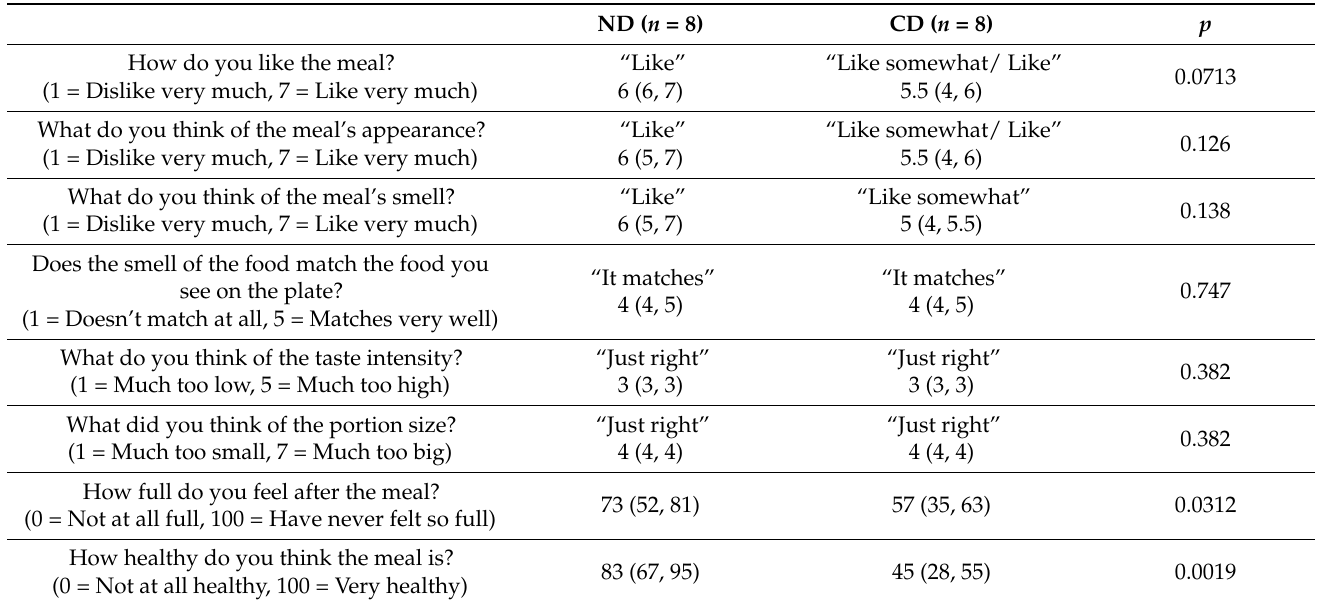
Table 3. Median (95% confidence interval (CI)) responses of meal evaluation questions in the healthy Nordic diet (ND) and control diet (CD)